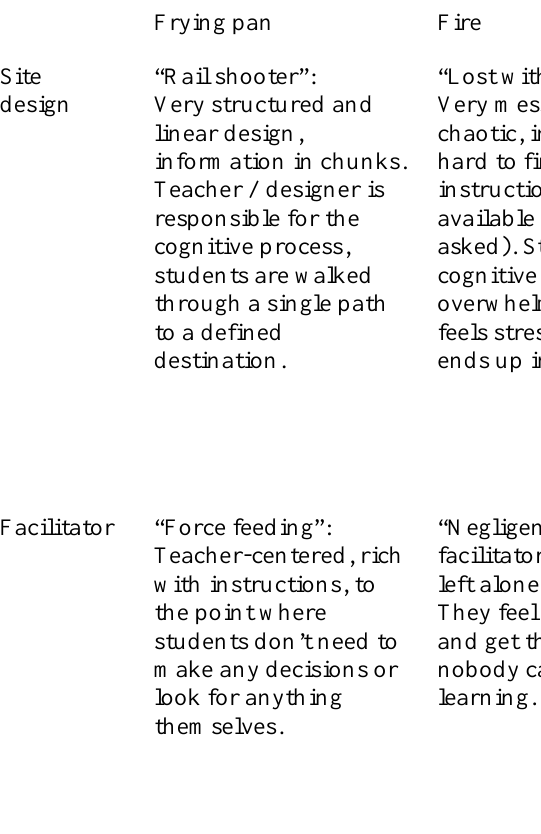
Balanced Authentic E-Learning